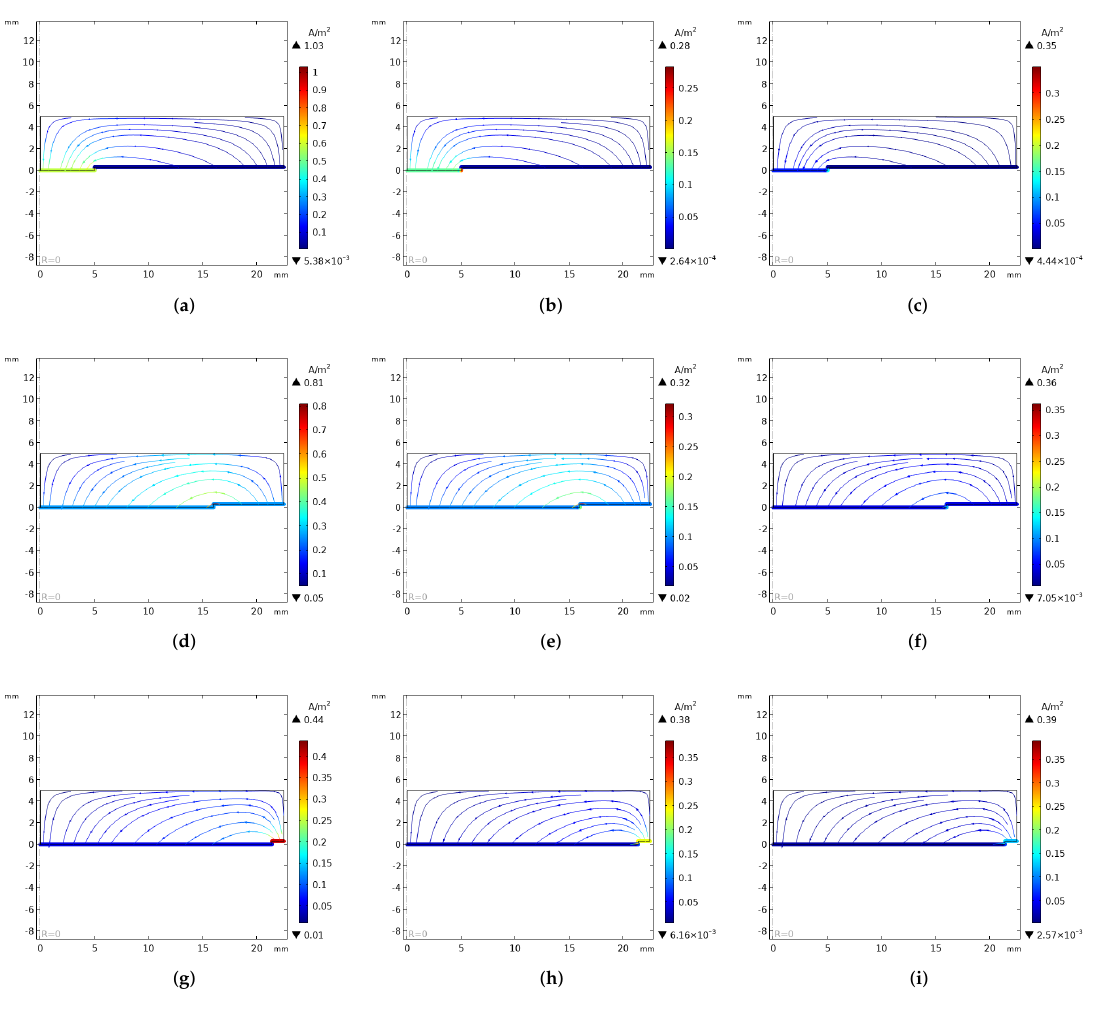
Figure 4. Simulated current densities on exposed steel (left side) and TSA coating (right side) without and with the influence of corrosion products and deposits. The lines with arrows indicate the electrolyte current density vector and the solid line represents the total current density on each surface. ( a ) 5% of exposed steel with E0 . ( b ) 5% of exposed steel with E1 . ( c ) 5% of exposed steel with E2 . ( d ) 50% of exposed steel with E0 . ( e ) 50% of exposed steel with E1 . ( f ) 50% of exposed steel with E2 . ( g ) 90% of exposed steel with E0 . ( h ) 90% of exposed steel with E1 . ( i ) 90% of exposed steel with E2 .